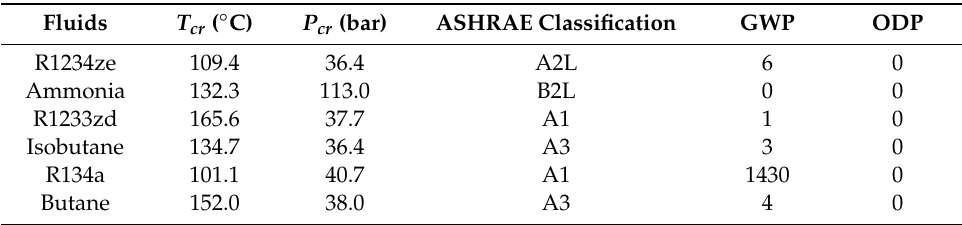
Table 1. Characteristics of the selected working